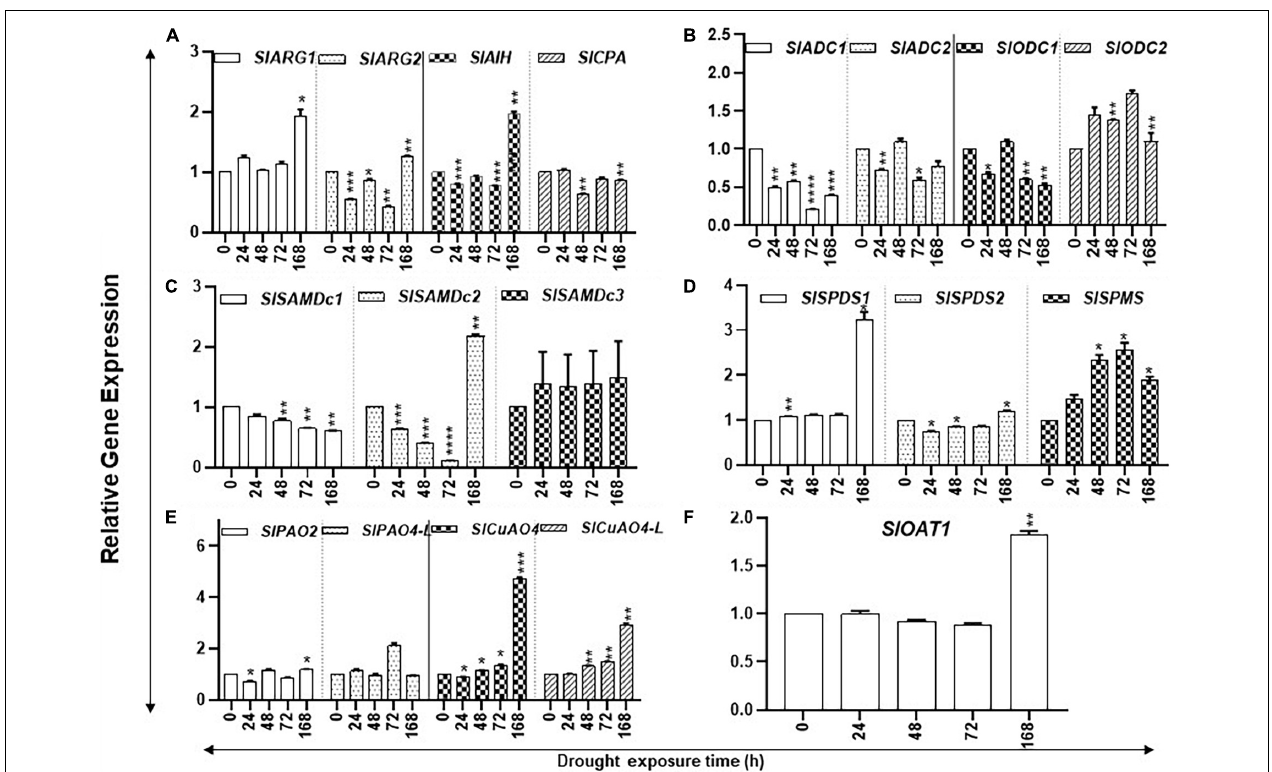
FIGURE 2 | Kinetics of drought-induced expression of PA metabolic pathway genes in tomato leaves. Total RNAs were extracted from tomato leaves harvested after withholding water for 0, 24, 48, 72, and 168 h, respectively. The steady state levels of transcripts of various PAs biosynthesis and catabolism genes were determined by qRT-PCR as described in section “Materials and Methods.” Genes included were of PUT biosynthesis ( SlARG1, 2 , SlADC1, 2 SlODC1, 2, SlAIH , and SlCPA ), SPD, and SPM biosynthesis ( SlSAMDc1, 2, 3, SlSPDS1, 2 , and SlSPMS ); and catabolism ( SlPAO2 and SlPAO4-Like; SlCuAO and SlCuAO4-like ) pathways, respectively. SlUBI3 and SlTIP41 were used as reference genes. Other details were the same as in Figure 1 . **** indicates significance at p -value of < 0.00005.